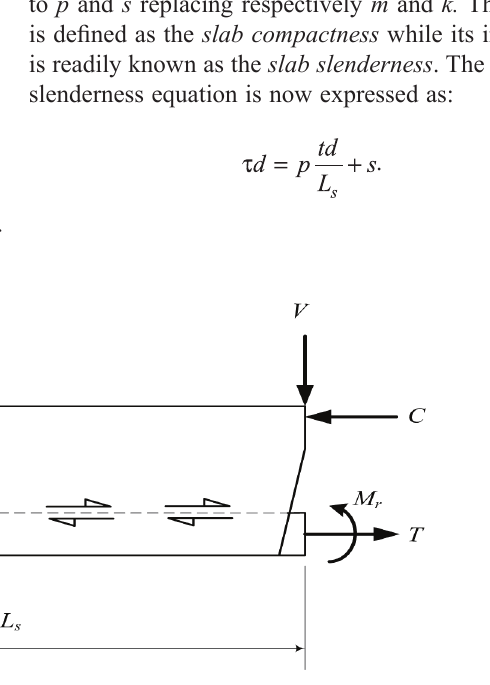
Fig. 5. Free body diagram of the shear span region for slab that fails by shear